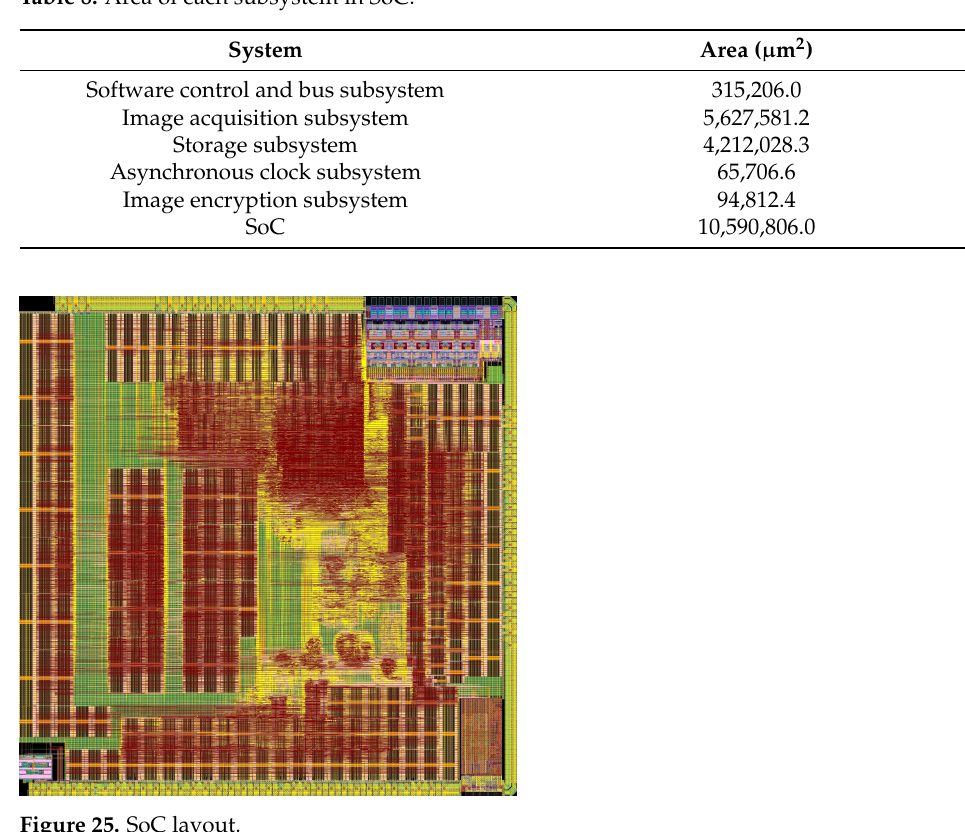
Table 8. Area of each subsystem in SoC.